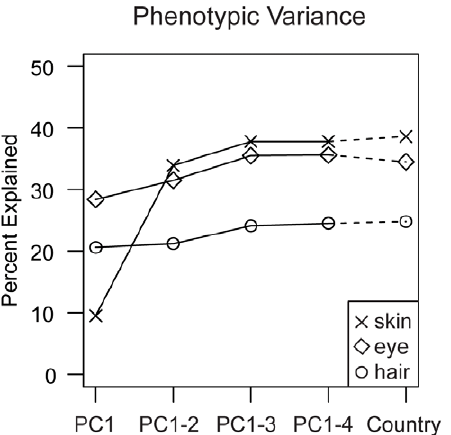
Figure 4. Percent phenotypic variance explained by increasing numbers of genetic PCs or country of sampling. Plotted is the percent phenotypic variance explained by genetic PC1 (PC1); PC1 and PC2 (PC1–2); PC1, PC2, and PC3 (PC1–3); PC1, PC2, PC3, and PC4 (PC1– 4); or country of sampling (country) in the GWAS cohort. The first three genetic PCs, similar to the country of sampling, explain a remarkably large proportion of the variation in pigmentation: 38.6/37.8%, 24.8/ 24.1%, 34.5/35.5% for the skin, hair, and eye pigmentation phenotypes by country of sampling/3 PCs. Including PC4 does not explain significantly more phenotypic